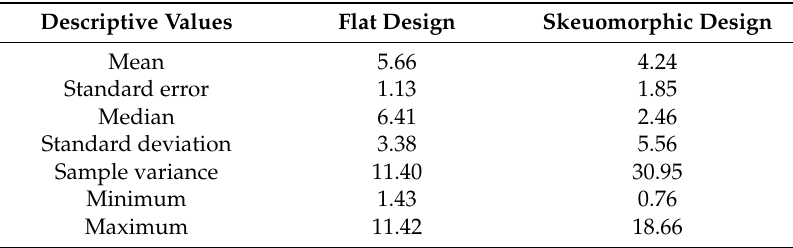
Table 5. Time from first fixation to